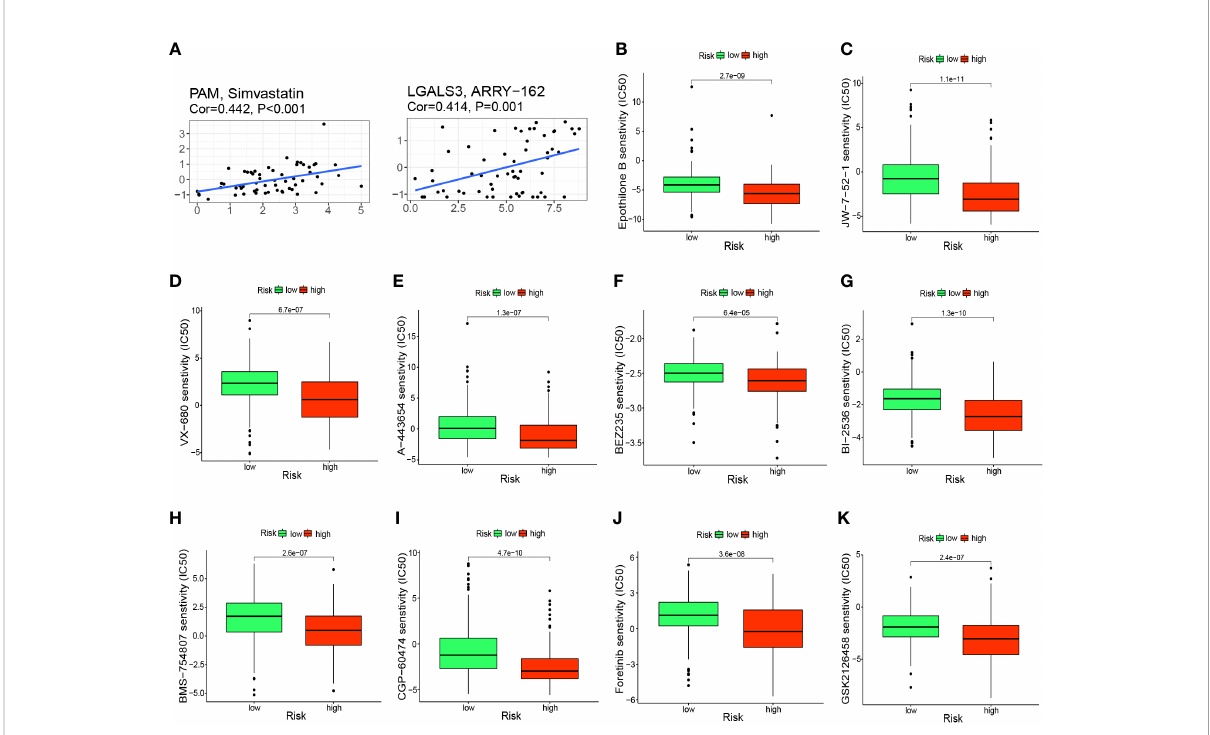
FIGURE 9 Predictionof potential anticancer drugsbased onsignaturegenes and risk groups. (A) PAMand LGALS3werepositivelycorrelated with the sensitivity of simvastatin and ARRY-162, respectively. (B – K) 10drugswith higher sensitivity in the high-riskgroup compared withthe